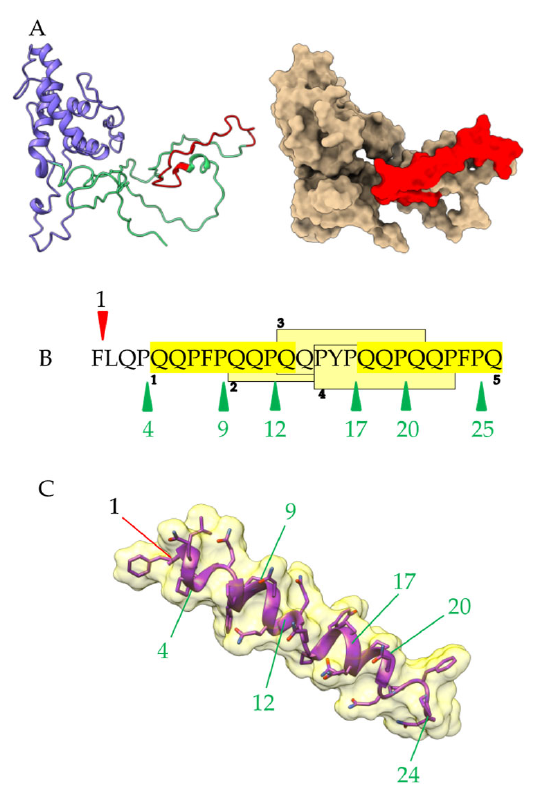
Figure 10. ( A ). Three-dimensional model built by homology modeling for the 26 mer-containing a-gliadin. The disordered N -terminal domain and the α -helical C -terminal domain are colored green and violet purple, respectively. The well-exposed 26 mer peptide on the molecular surface of α -gliadin is colored red. ( B ). Potential cleavage sites for polyl-peptidase (numbered green arrows) predicted along the amino acid sequence of the 26 mer peptide. The 5 potential overlapping celiac peptides occurring along the 26 mer peptide are highlighted in yellow. ( C ). Three-dimensional model in the extended conformation built for the 26 mer peptide, showing the exposure of the potential cleavage sites for pepsin (numbered red line), and prolyl-peptidase (green lines).